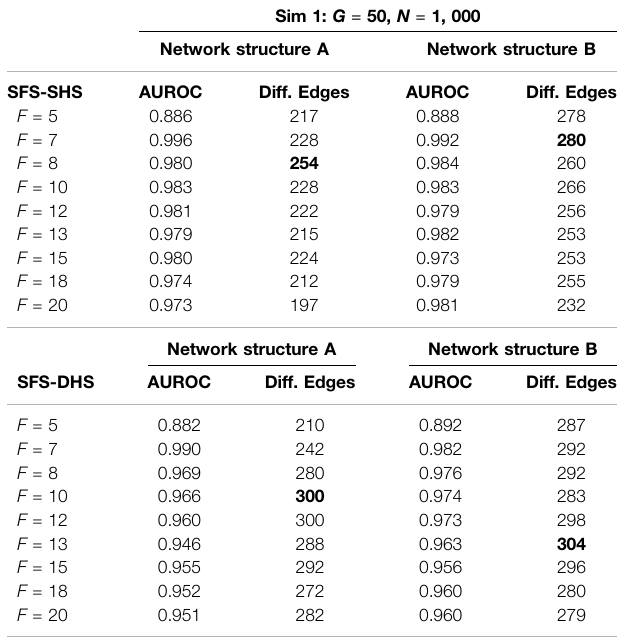
TABLE 2 | Example comparisons of AUROC and number of signi fi cant differential edges (Diff. Edges) from Sim 1 when different choices of F are input into the SFM-SHS and SFM-DHS methods. Results are presented from the bootstrap estimation